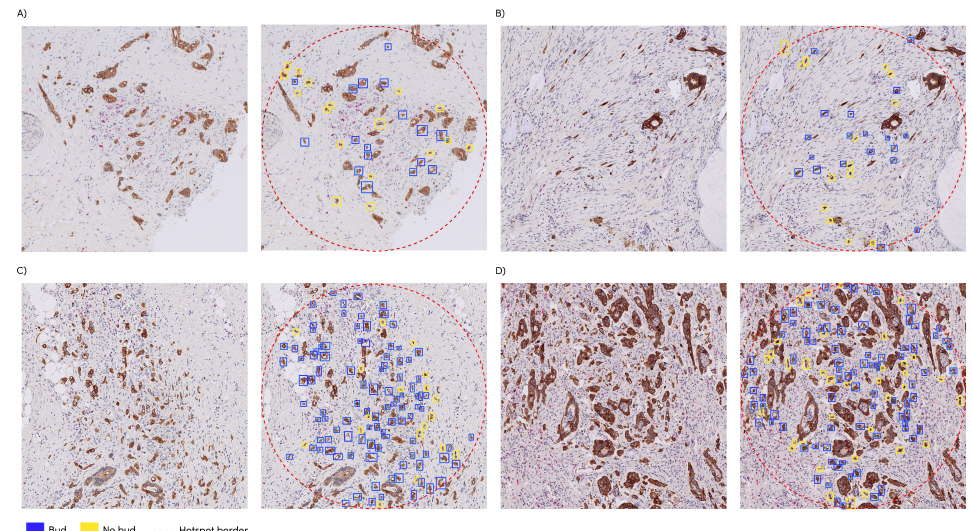
Figure 4. Manual selected hotspots with the automatic detections as overlay: ( A ) manual count: 13, automatic count: 17; ( B ) manual count: 20, automatic count: 15; ( C ) manual count: 23, automatic count: 86; ( D ) manual count: 24, automatic count: 72.